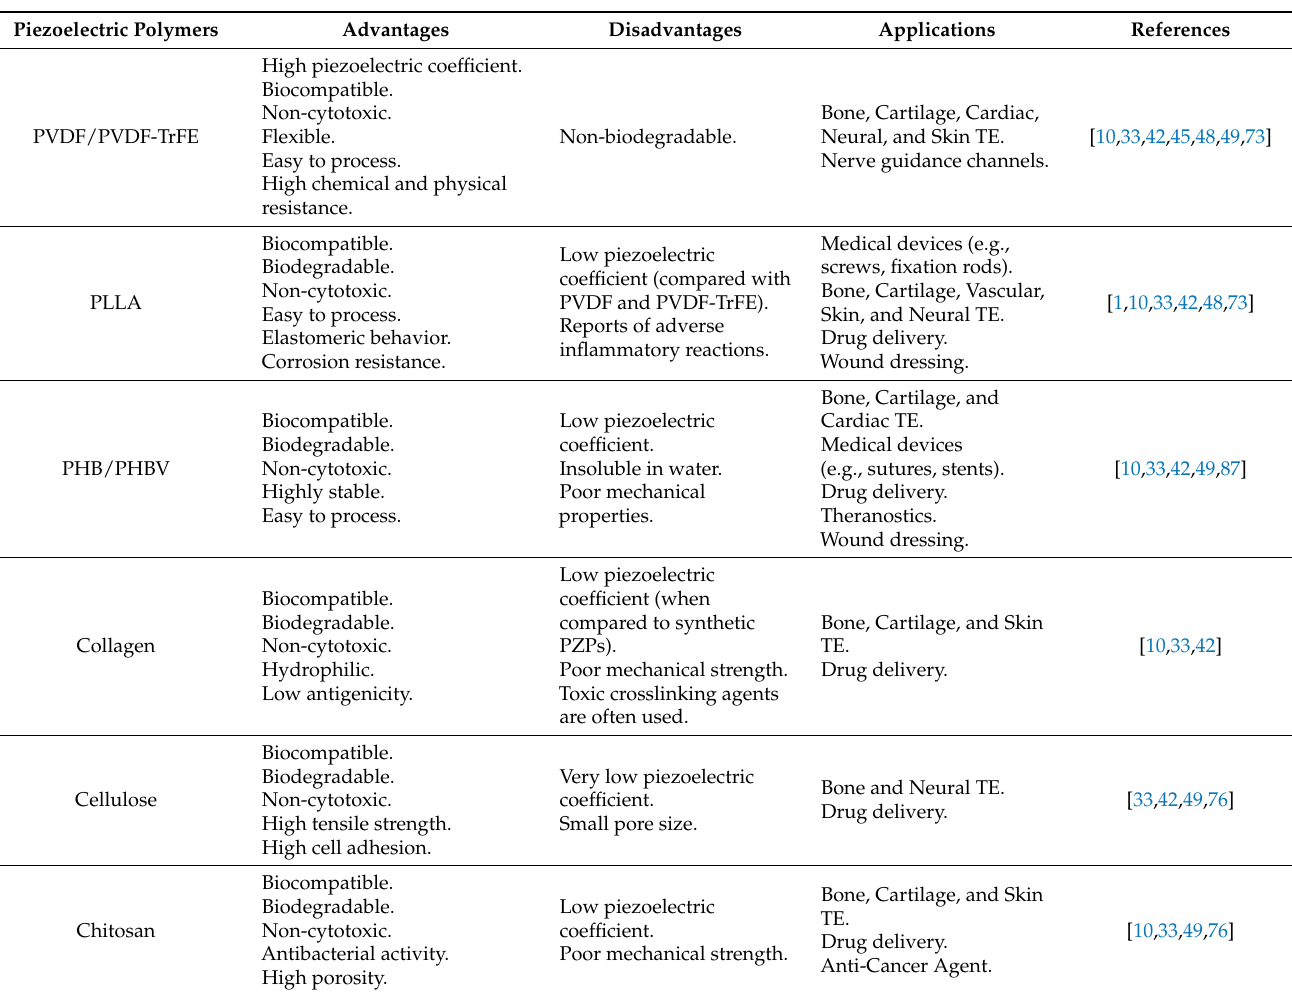
Table 5. Summary of the main piezoelectric polymers that have been applied so far in scaffold-based TE